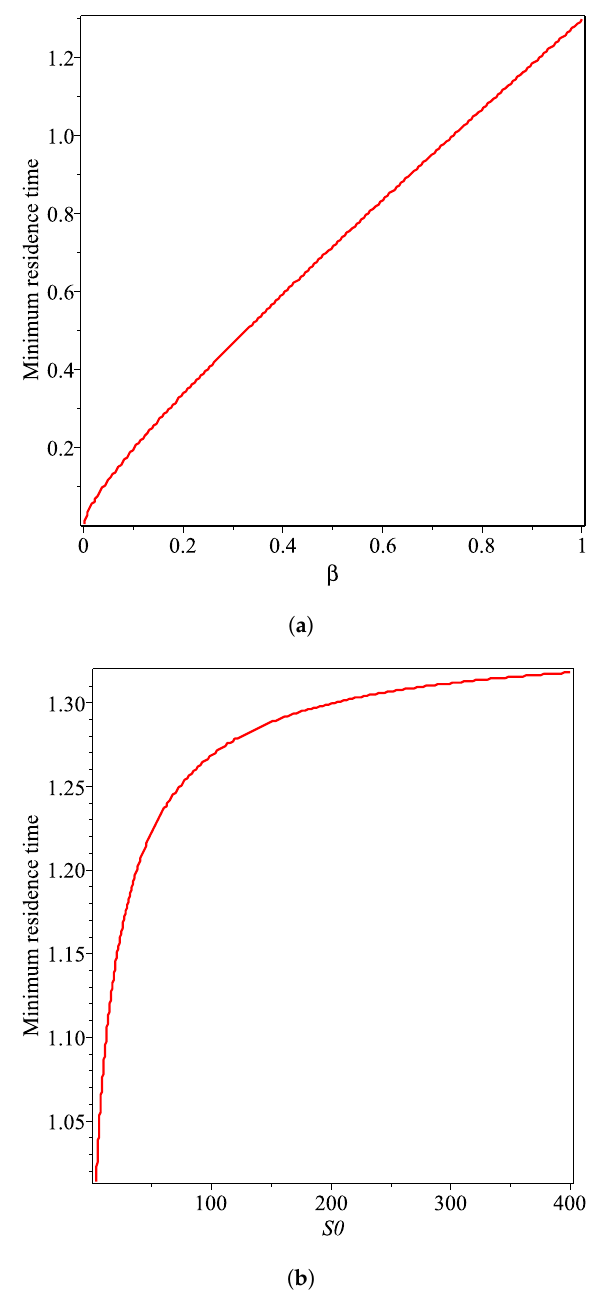
Figure 2. Unfolding diagram for the minimum residence time in Figure 1a as a function of β and the influent concentration ( S 0 ). The value of the parameters stated in Table 1. ( a ) Minimum residence time versus parameter S 0 . ( b ) Minimum residence time versus parameter S 0